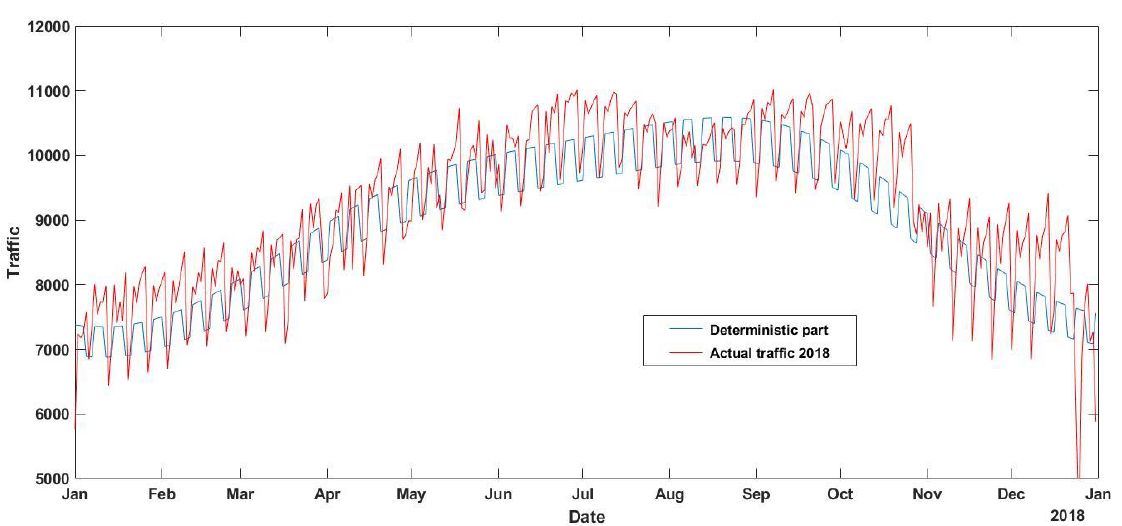
Figure B1. Actual Flights 2018 and mean of simulated flights for this